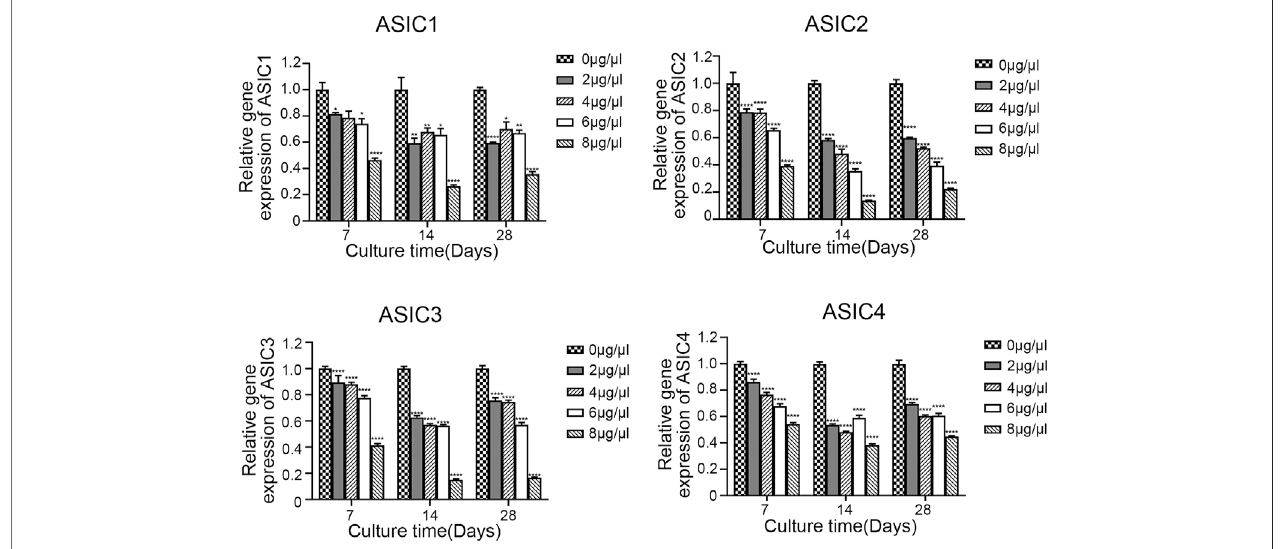
FIGURE5| TherelativegeneexpressionofASICsubunits(ASIC1,ASIC2,ASIC3,andASIC4)graduallydecreasedwithincreasingSa12bconcentration.*indicates p < 0.05; ** indicates p < 0.01; *** indicates p < 0.001 when the control group ( Sa12b = 0 μ g/ μ l) was compared with the other groups.